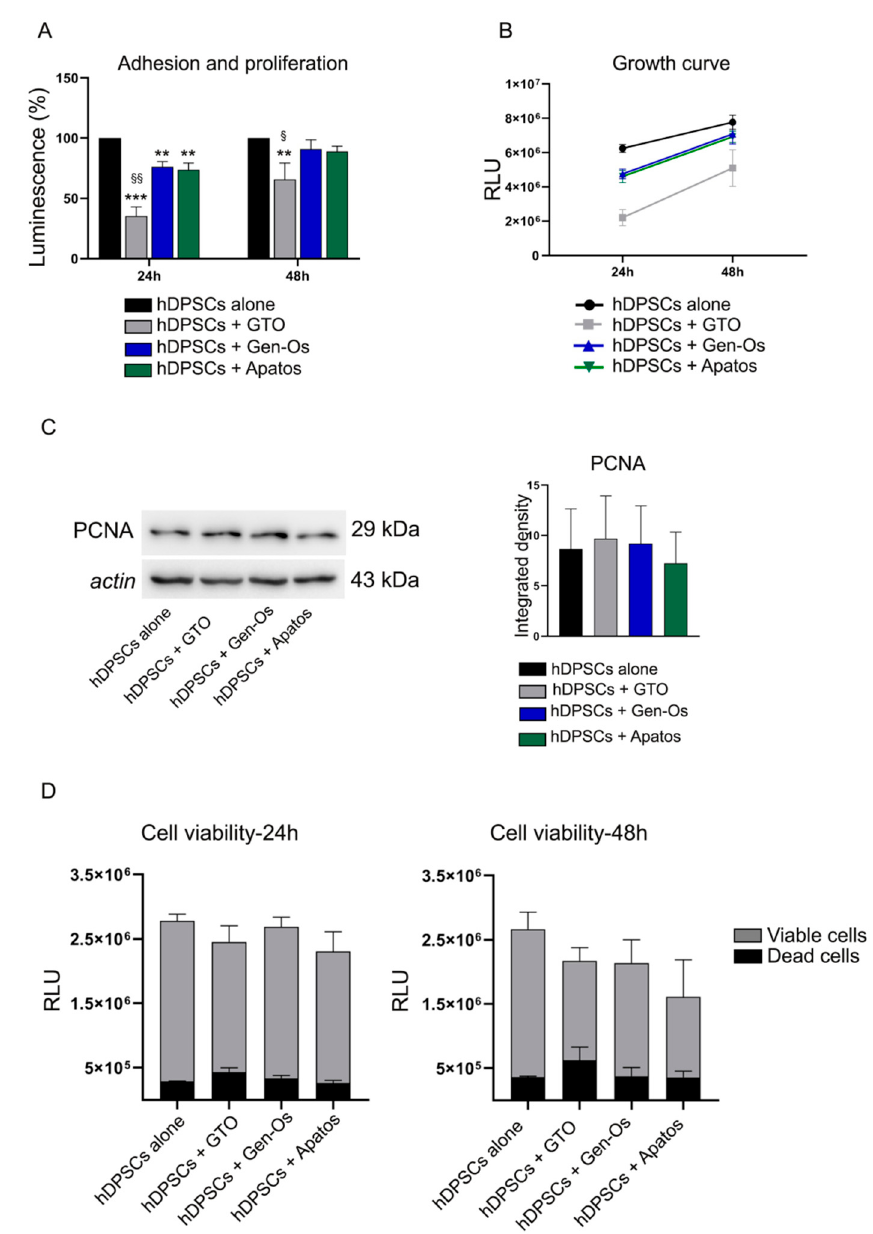
Figure 3. Stem cell adhesion, proliferation, and viability after BSB treatments. ( A ) Cell adhesion (24 h) and proliferation (48 h) of attached hDPSCs treated with BSBs. Histograms report a statistically significant reduction in stem cell adhesion in all BSB-treated groups, compared to the control group (** p < 0.01, *** p < 0.001 vs. hDPSCs alone). GTO-treated hDPSCs show a statistically significant reduction in both stem cell adhesion and proliferation, when compared to either control group or Gen-Os and Apatos-treated groups (** p < 0.01 vs. hDPSCs alone; § p < 0.05, §§ p < 0.01 vs. hDPSCs + Gen-Os, hDPSCs + Apatos). Data are reported as % of luminescence ± SD. ( B ) Growth curve assesses the effects of each BSB on stem cell growth after 48 h of treatment. The proliferating cells curve reveals the same increasing growth trend in each group from 24 to 48 h of treatment. Data are reported as relative luminescence unit (RLU) ± SD. ( C ) Western blot analysis of PCNA in hDPSCs treated with BSBs for 48 h. The densitometric analysis shows no statistically significant differences among the experimental groups. ( D ) Stem cell viability assay after 24 h and 48 h of BSB treatment. Histograms reveal no statistically significant differences in terms of cell death in both 24 h and 48 h-treated groups, compared to the control group (black bars). Data are reported as RLU ±